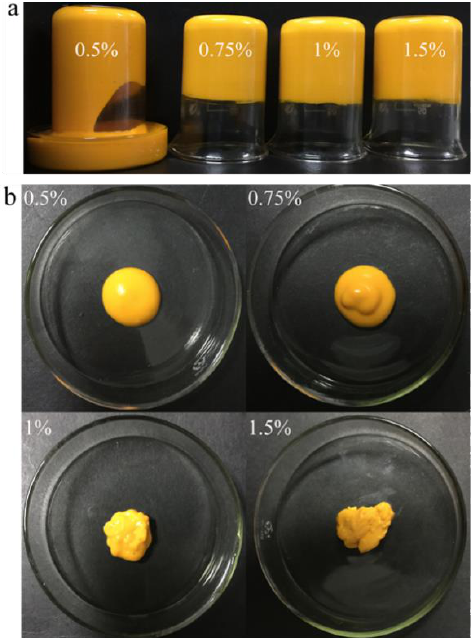
Figure 1. The visual images of Pickering emulgels at different concentrations of gliadin nanoparticles (GNPs) (0.5%−1.5%, w / v ) in ( a ) beaker and ( b ) culture dish.